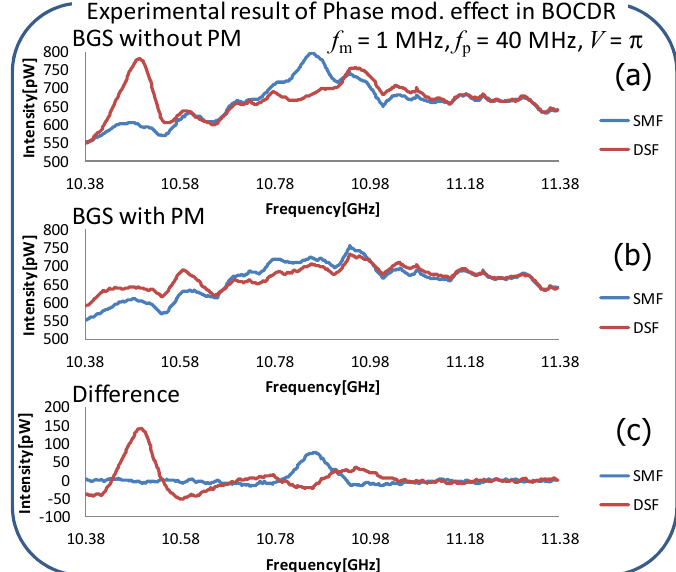
Figure 35. Experimental results of the BOCDR outputs ( a ) without the PM and ( b ) with the PM, respectively [84]; ( c ) Subtracted spectra; signal spectrum for the DSF section and the SMF section is clearly shown by the red and the blue curves, respectively.